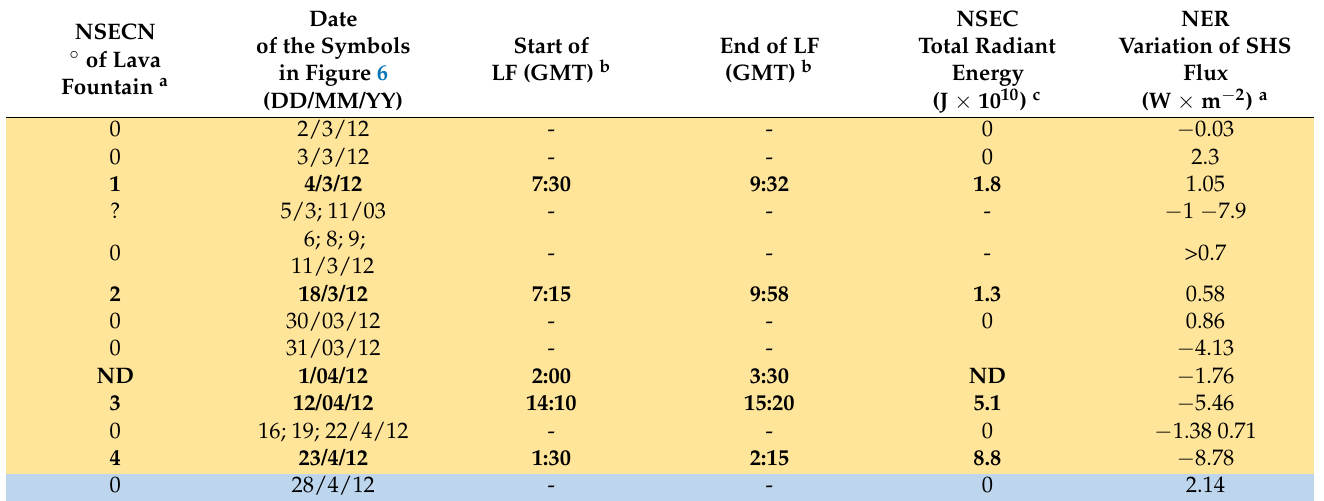
Figure 5. Time variation of the heat flux retrieved from the temperature monitoring of the shallow profile of the ground. The labeled peaks are listed in Table 1; the different colors in the background indicate the same volcanic phases as in Figure 4. Table 2. Timing and relative intensity of the data reported in Figures 6 and 7. a Original data of SHS Flux reported in Figure 6; “0” and “?” in the first column stand for the daily variations recorded when no lava fountain resulted by the references, ND stands for the undetermined radiant energy, N ◦ 1–4 stand for the lava fountain evaluated by Bombrum et al. [30]. b Timing of the paroxysms from Viccaro et al. [28]. c Total radiant energy values from Bombrum et al. [30]. The bold characters indicate the data from previous references, and the red and blue labels underline the respective background and anomalous variations of the SHS Flux evaluated in a time window of 48